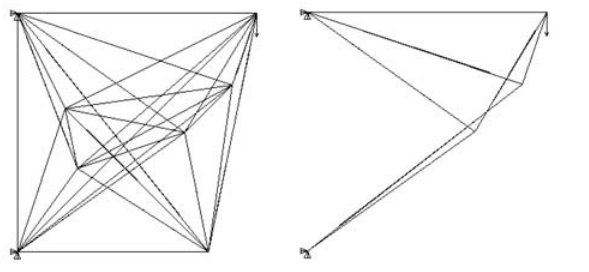
Fig. 6. 8-node truss system and the best solution